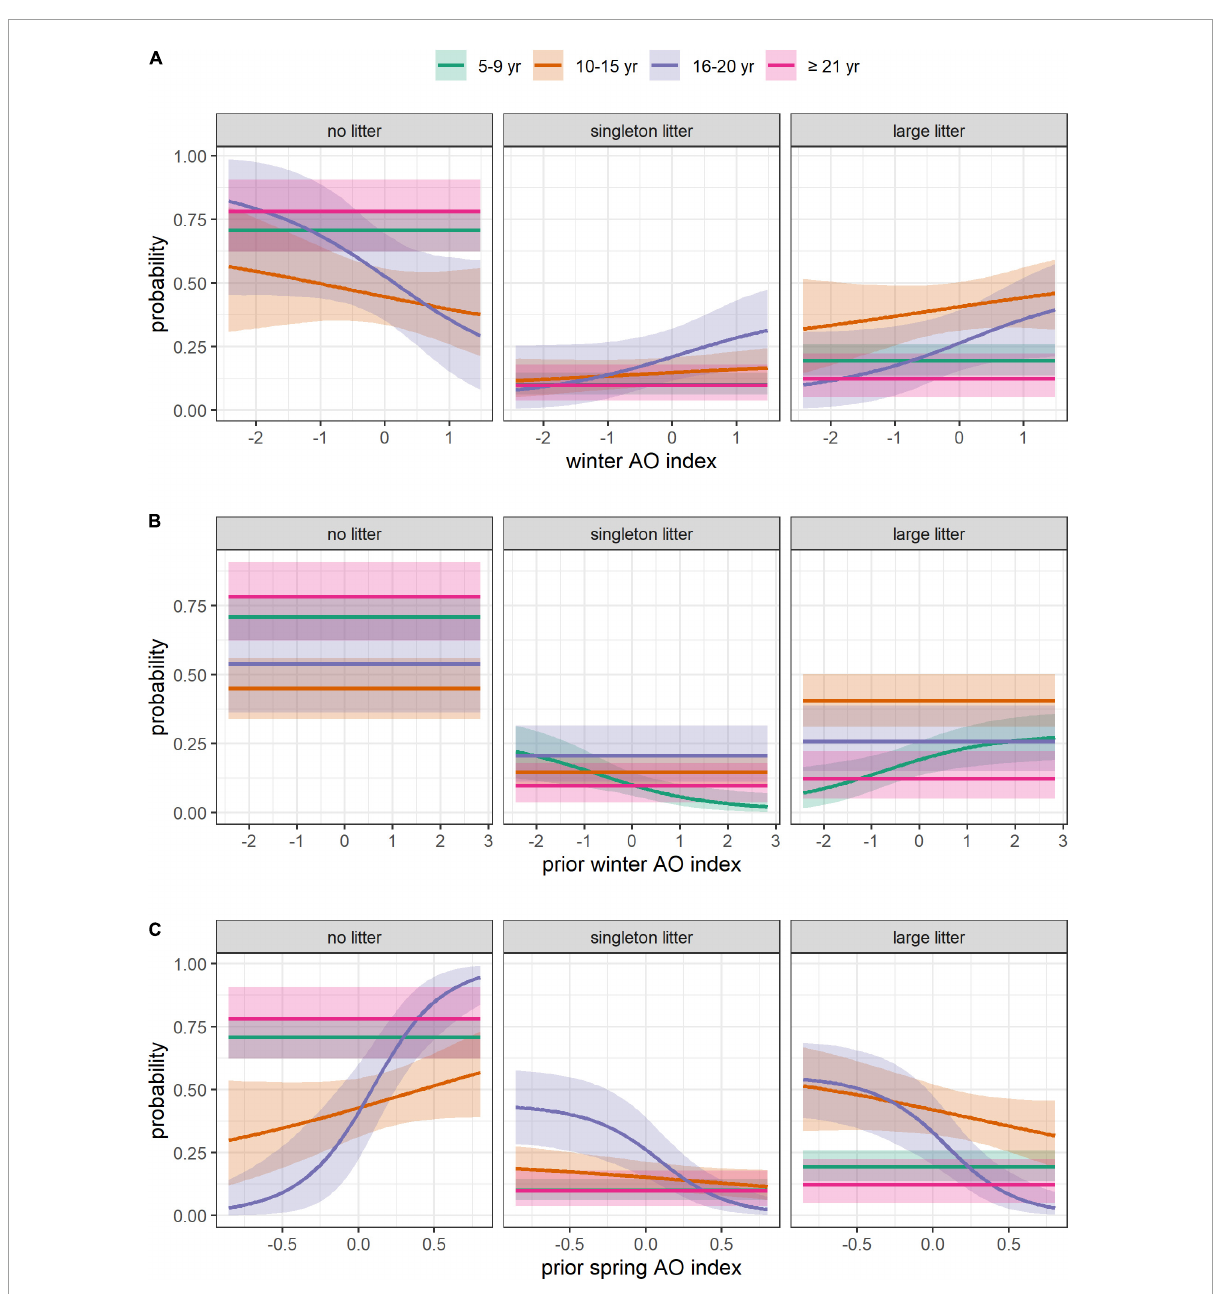
FIGURE7 Effect of Arctic oscillation on the absolute probability of having no litter, a singleton litter, or a large litter, depending on female’s age. (A) Effect of the mean AO index over the winter of the year of capture. (B) Effect of the mean AO index over the winter of the year preceding capture. (C) Effect of the mean AO index over the spring of the year preceding capture. The mean (solid line) and 95% CRI (shading) are provided. All the covariates other than the one represented in each panel were set at their mean value ( DateCapture = 104, i.e., April 14, Size = 195 cm, DateBreakUp = 174, i.e., June 23, WinterAO = –0.06, PriorWinterAO = 0.01, PriorSpringAO =